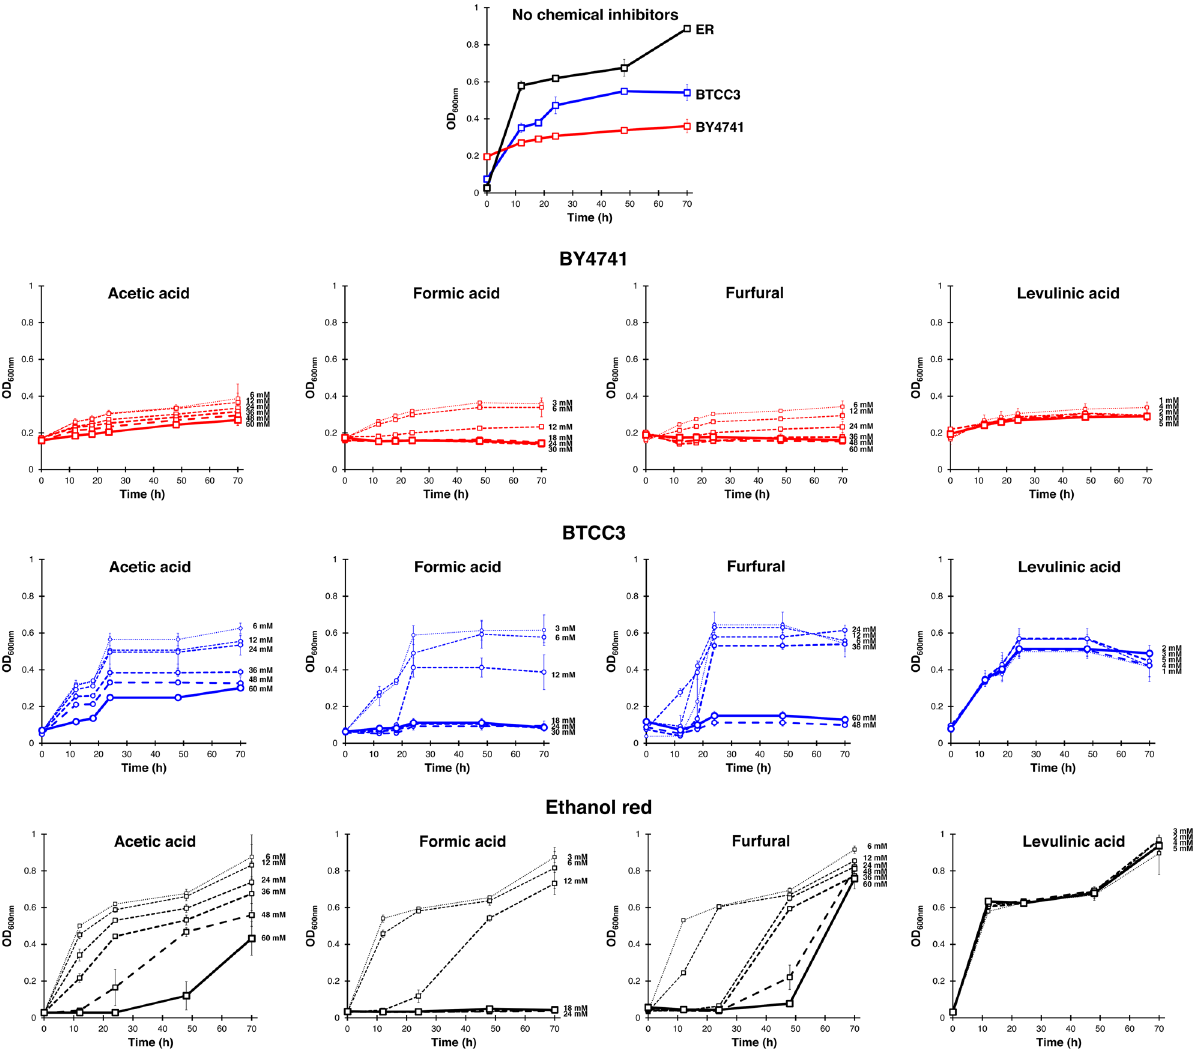
Figure 1. The cell growth of Saccharomyces cerevisiae BTCC3 (blue boxes), BY4741 (red boxes) and Ethanol-red (black boxes) strains in YNB medium + amino acids with and without single chemical inhibitors supplemented. Values represent the average measurement of three biological replicates. Error bars represent the standard deviation of